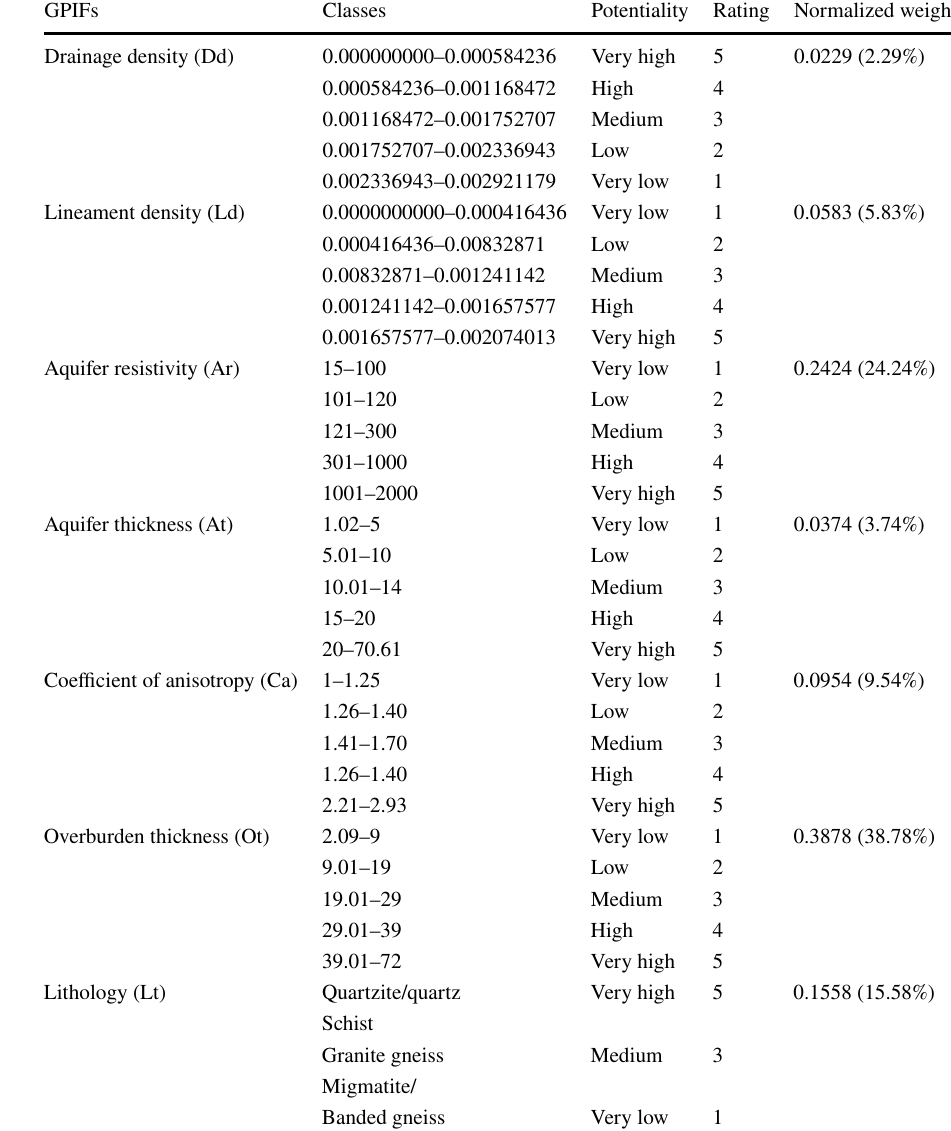
normalized weight of the